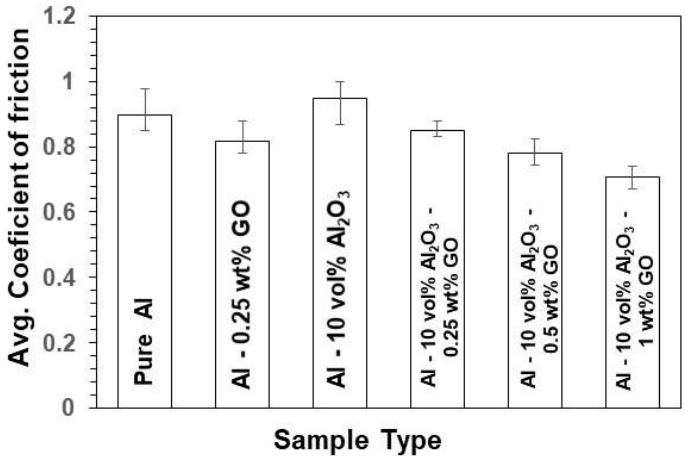
Figure 5. Variation of average coefficient of friction for all the tested samples at a load of 3 N, sliding speed of 0.1 m/s, and a sliding distance of 100 m.